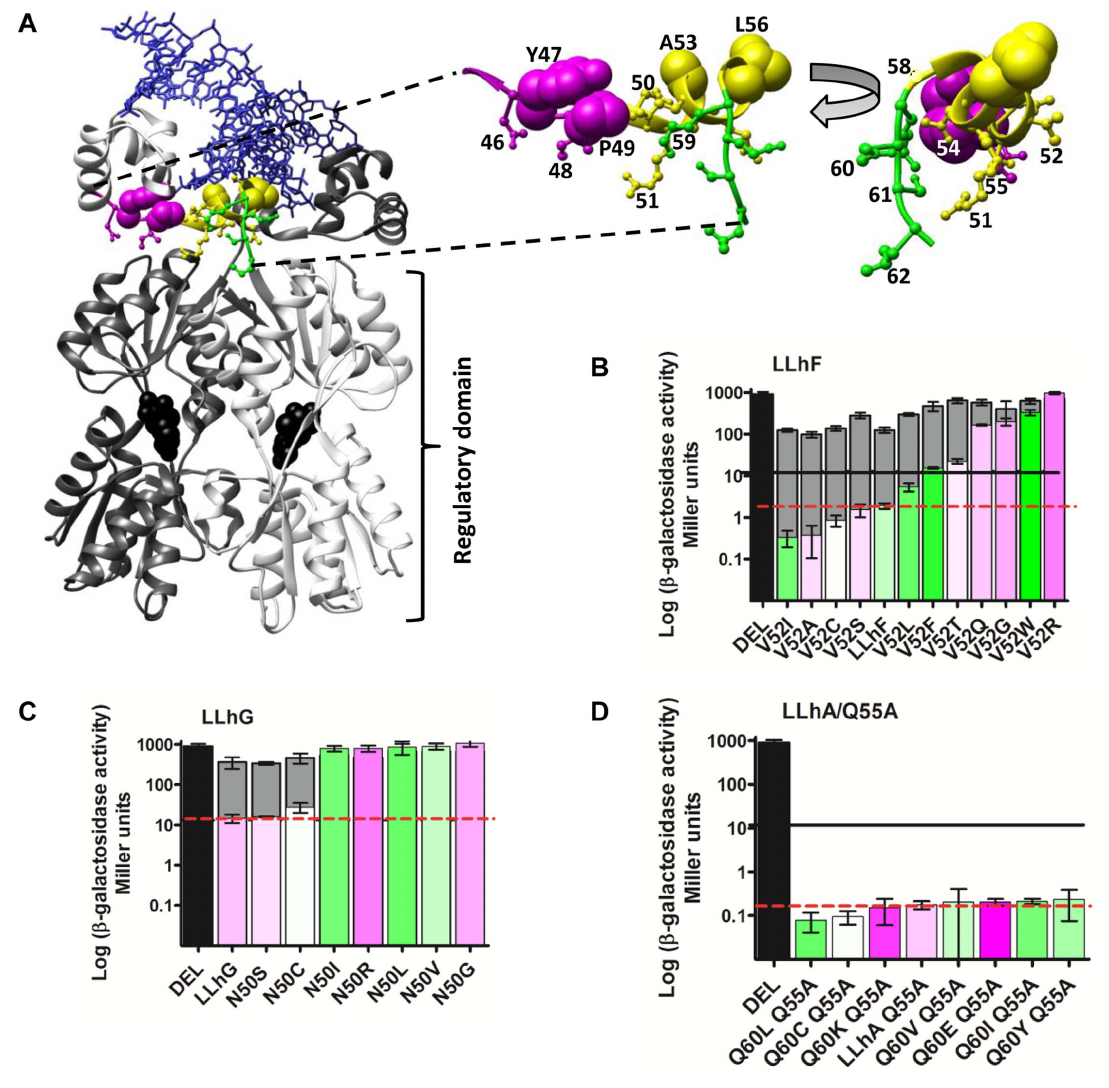
Figure 1. Structure and function of the LacI/GalR proteins. (A) Structure of LacI/GalR homodimer (pdb 1efa; [39]). One monomer is shown in white and the other in gray. DNA is shown with blue wires. The linker region is magenta (positions 45–49), yellow (50–58), and green (59–62). The YPAL motif is in space-filling; positions mutated in this study are in ball-and-sticks. Black space-filling shows an allosteric effector bound to the regulatory domain. On the right, the linker is enlarged and shown in two different views. (B–D) Representative functional data for LacI/GalR synthetic homologs. Repression of the lac operon was determined in the absence (front series) and presence (back series) of allosteric effector. Lower values correspond to tighter repression. ‘‘DEL’’ (black bar) shows b -galactosidase activity in the absence of repressor protein. Below 13 Miller units (solid black line), any change in repression impacted bacterial growth [17]. The red dashed lines indicate the activities of the starting proteins that are listed in Table 1. Error bars are the standard deviation of 2–4 independent bacterial colonies, each in quadruplicate or duplicate. Color coding of the front series represents amino acid hydrophobicity (green to magenta represents highest to lowest hydrophobicity); note the poor correlation with repression. Other physico-chemical scales are listed in Table S20 in Data S2 and mapped to repression data in Figures S25–S87 in Data S5, Data S6, and Data S7. (B) Rheostat example. (C) Toggle-like example (note that the red line overlaps the black line in this example). (D) Neutral example.